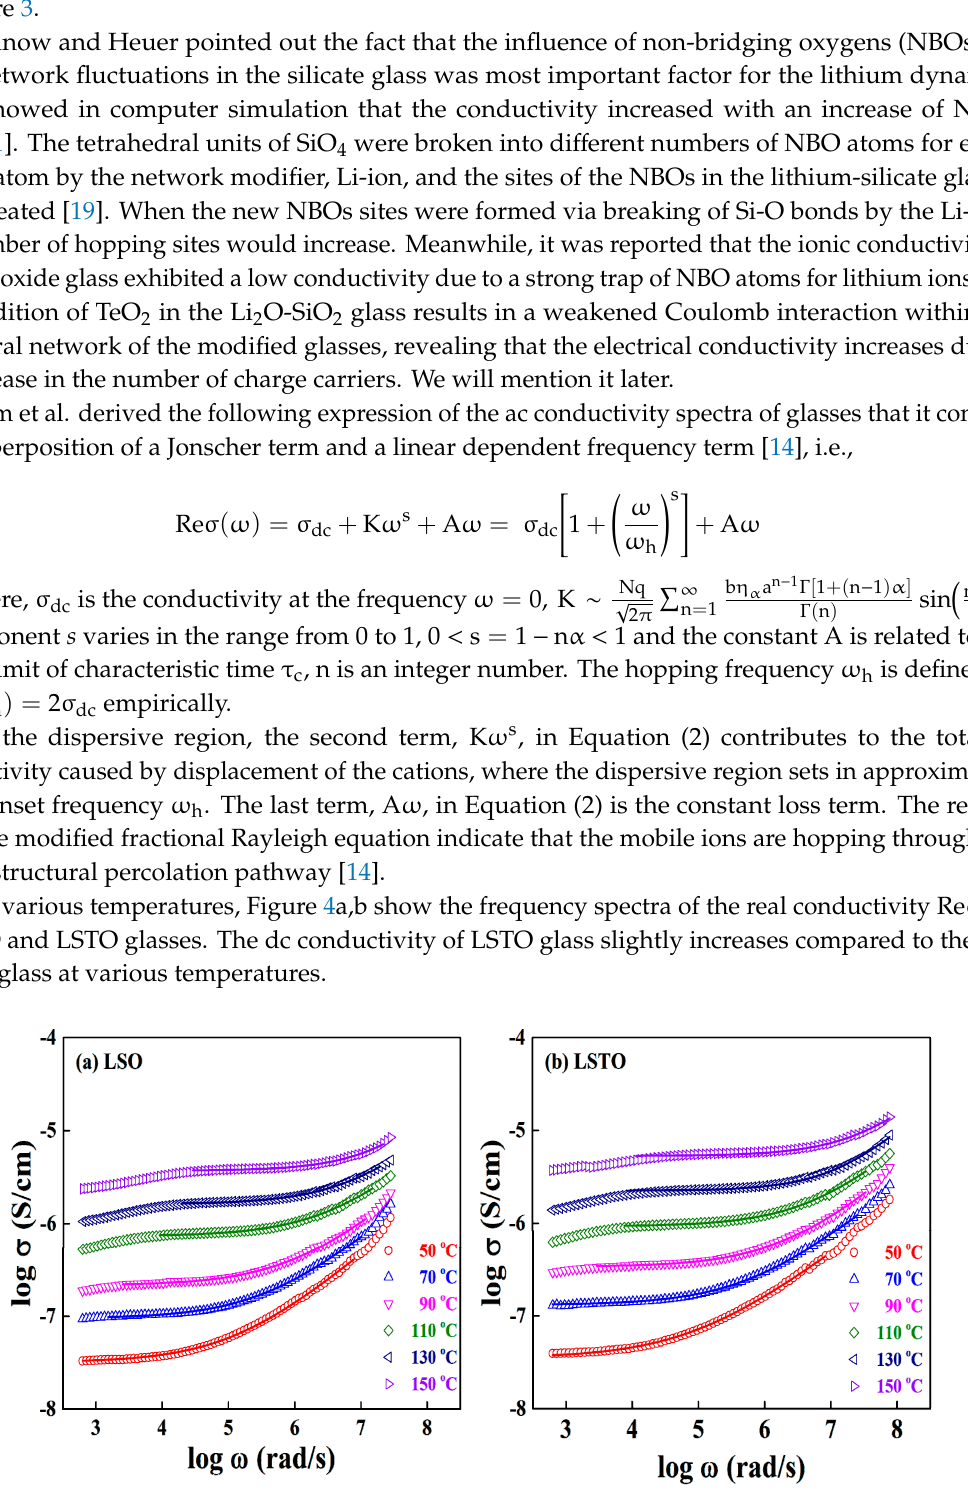
Figure 4. At various temperatures, frequency spectra of the real conductivity σ ( ω ) for ( a ) LSO and ( b ) LSTO-glasses. To obtain the solid lines, we do fit the experimental data by using a Jonscher’s power law in Equation (2).